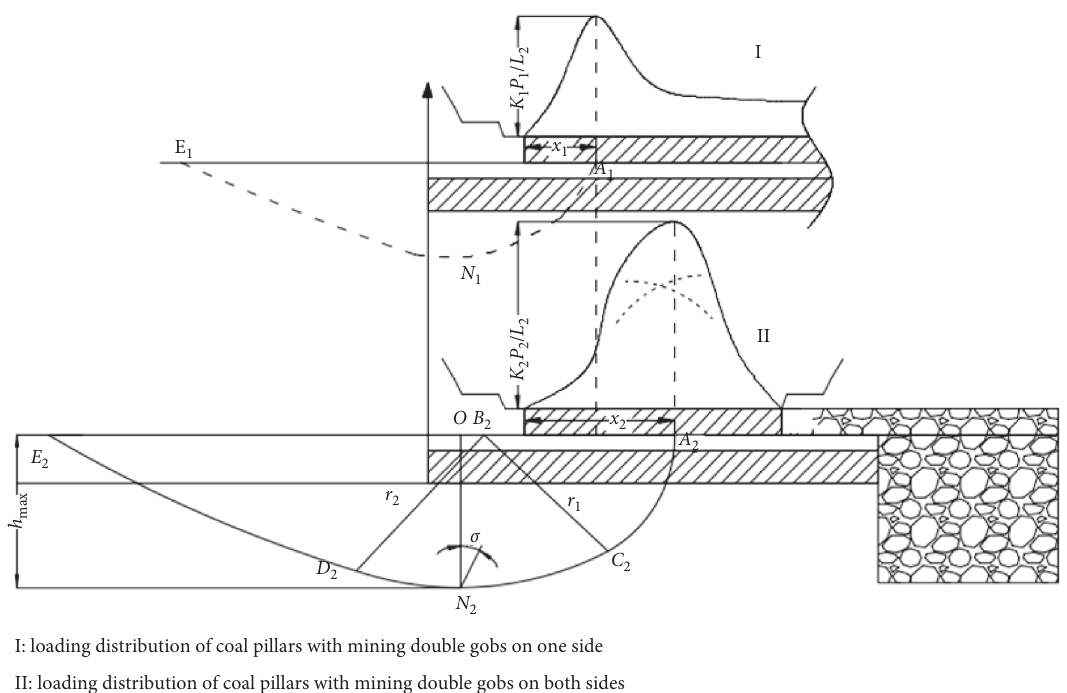
Figure 7: Mechanical model of floor failure caused by stress superposition of extremely close double-layer stepped coal